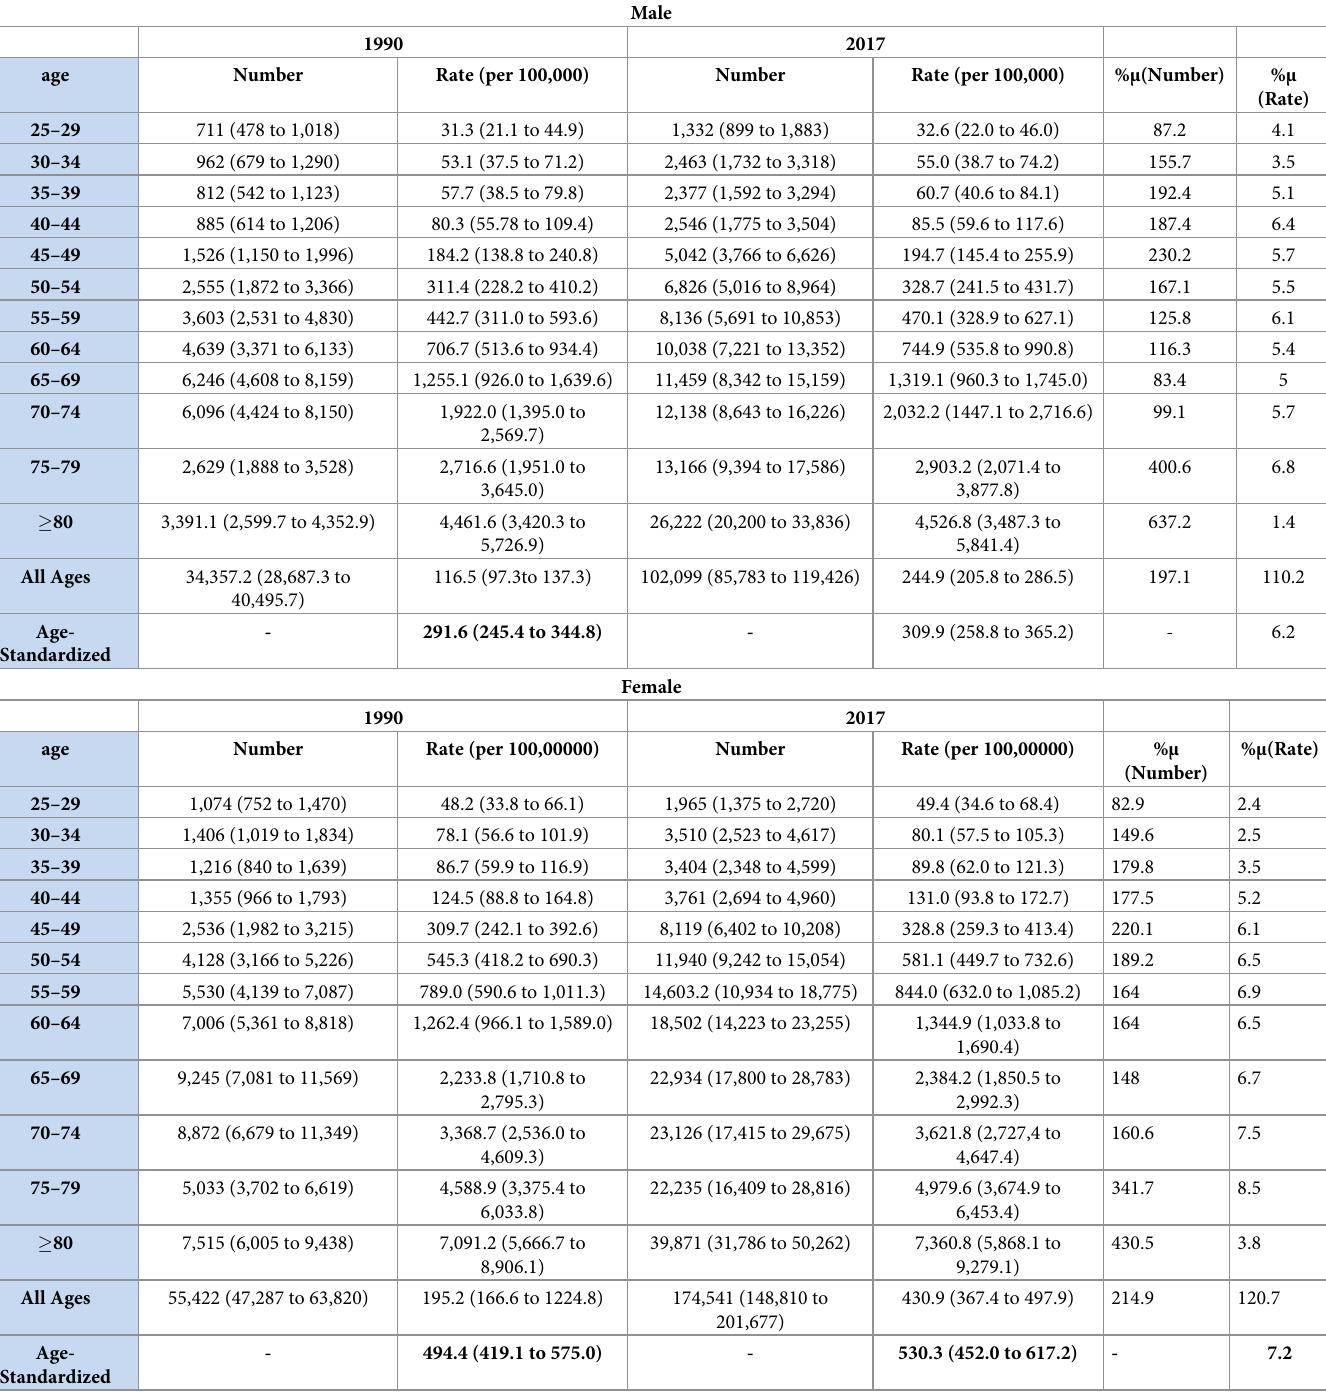
Table 1. Prevalence of HHD in men and women in Iran in 1990 and 2017.